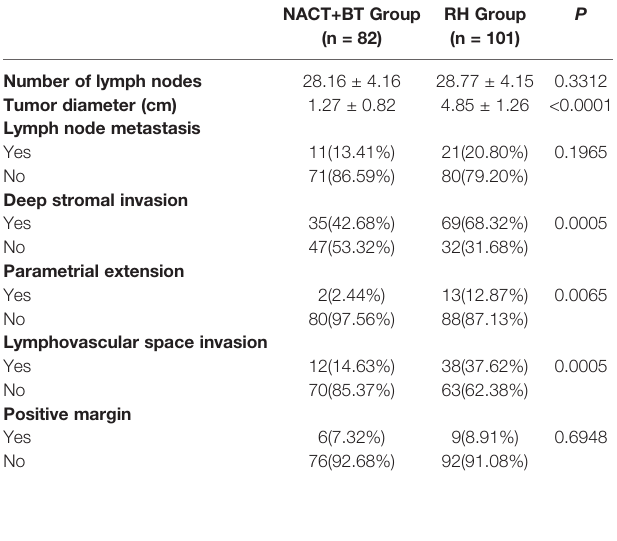
TABLE 3 | Comparison of surgical pathological